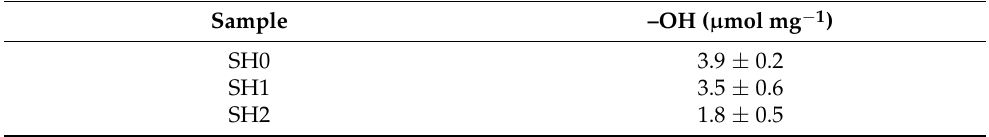
Figure 4. ( a ) Functionalization scheme of ZnO-Ts ( 1 ) with 5 ′ -DMT-3 ′ -phosphoramidite-thymidine nucleotide ( 2 ) via coupling reaction; the removal of 5 ′ -DMT from thymidine nucleotide-bounded on ZnO-Ts surface ( 3 ) via detritylation reaction provided the ZnO-Ts surface ( 4 ). ( b ) Representative images of DMT cation bright red-orange colored solution resulting from detritylation where the quantity of the released DMT cation is measured by UV-vis spectroscopy at 503 nm. Table 3. Quantification of reactive hydroxyl (–OH) groups.